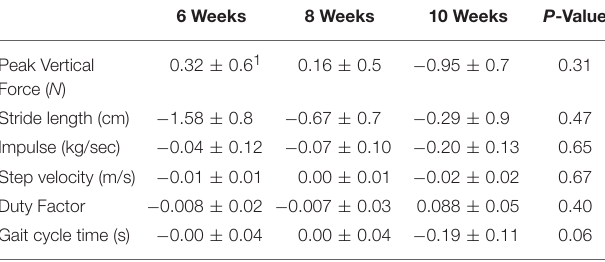
1 Negative numbers indicate the left-side data was greater than the right-side